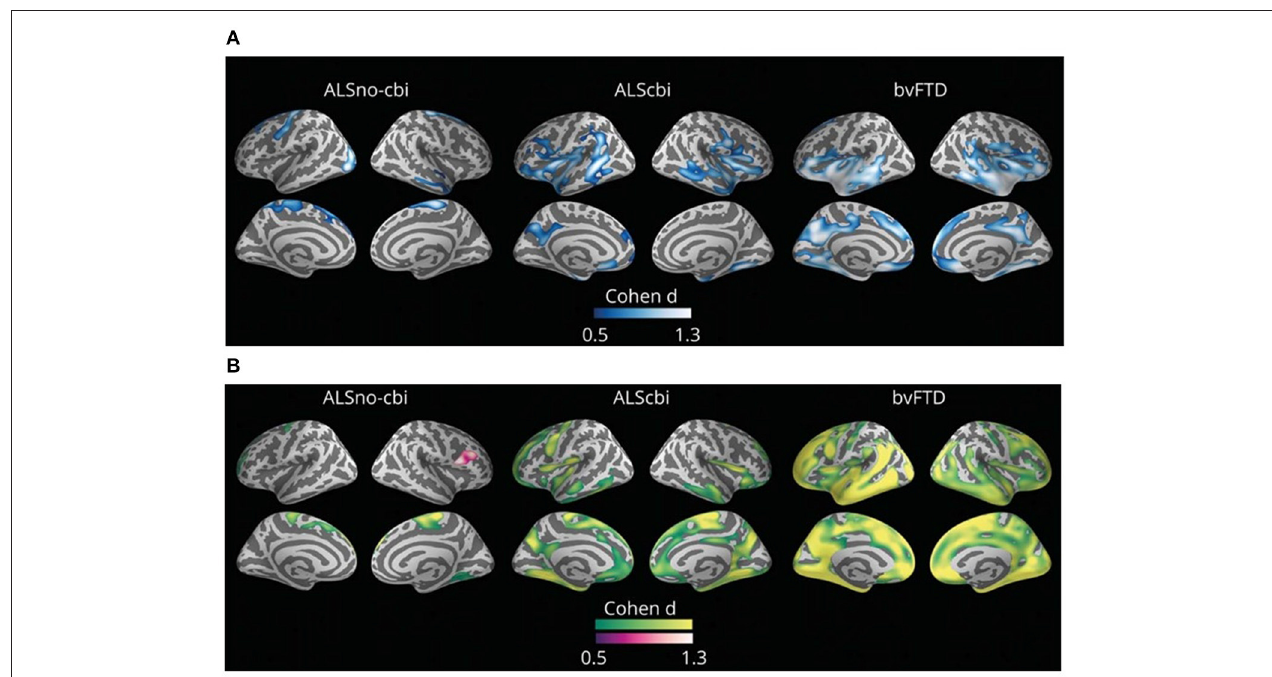
FIGURE 2 | Group comparisons between those with amyotrophic lateral sclerosis (ALS) without cognitive or behavioral impairment (ALSno-cbi; left column), those with ALS with cognitive or behavioral impairment (ALScbi; middle column), and those with the behavioral variant of frontotemporal dementia (bvFTD; right column) compared to controls for (A) cortical thickness and (B) cortical mean diffusivity. Regions in blue represent thinner cortex; regions in green represent higher cortical mean diffusivity; and regions in purple represent lower cortical mean diffusivity. All analyses were adjusted for age, sex, education, and MRI equipment. Only clusters that survived family-wise error correction p < 0.05 are shown. ALSno-cbi, Amyotrophic Lateral Sclerosis without cognitive and behavioral impairment; ALScbi, Amyotrophic Lateral Sclerosis with cognitive and behavioral impairment; bvFTD, Behavioral variant of frontotemporal